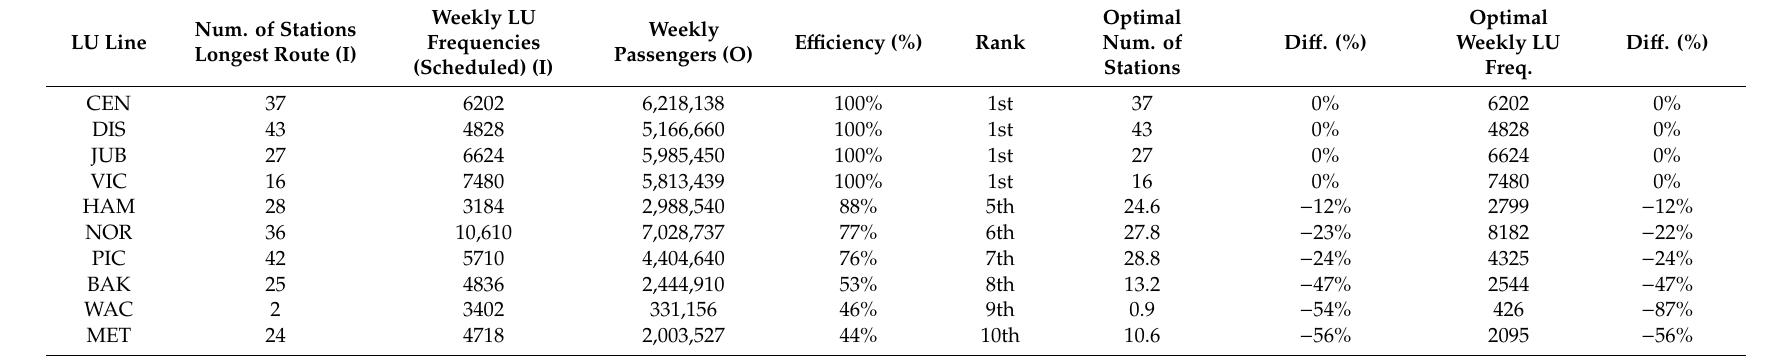
Table 9. Optimal LU input projections of the URT lines DEA